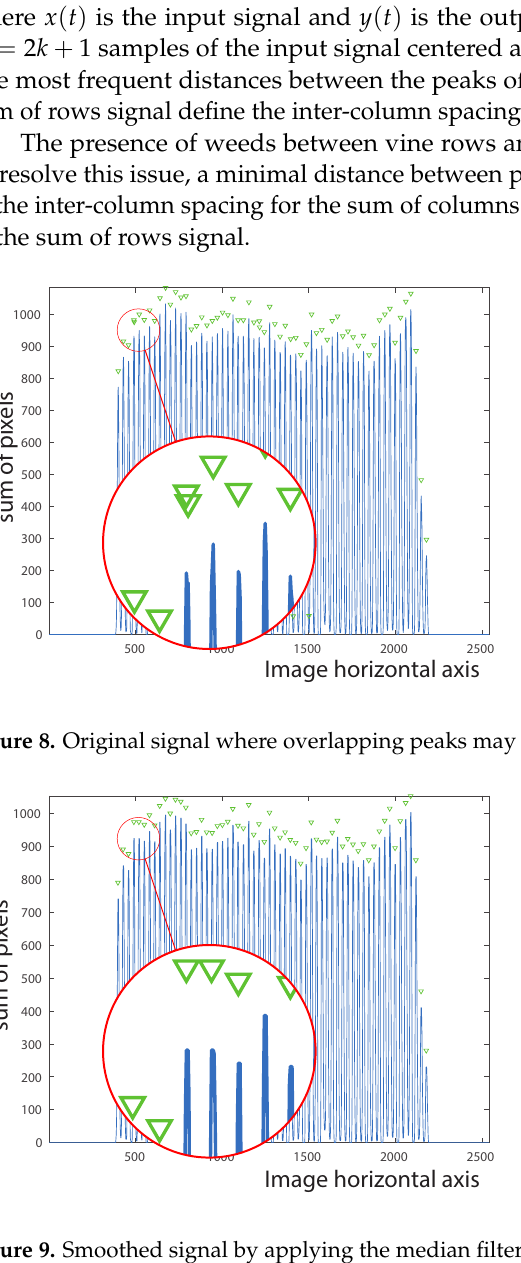
Figure 9. Smoothed signal by applying the median